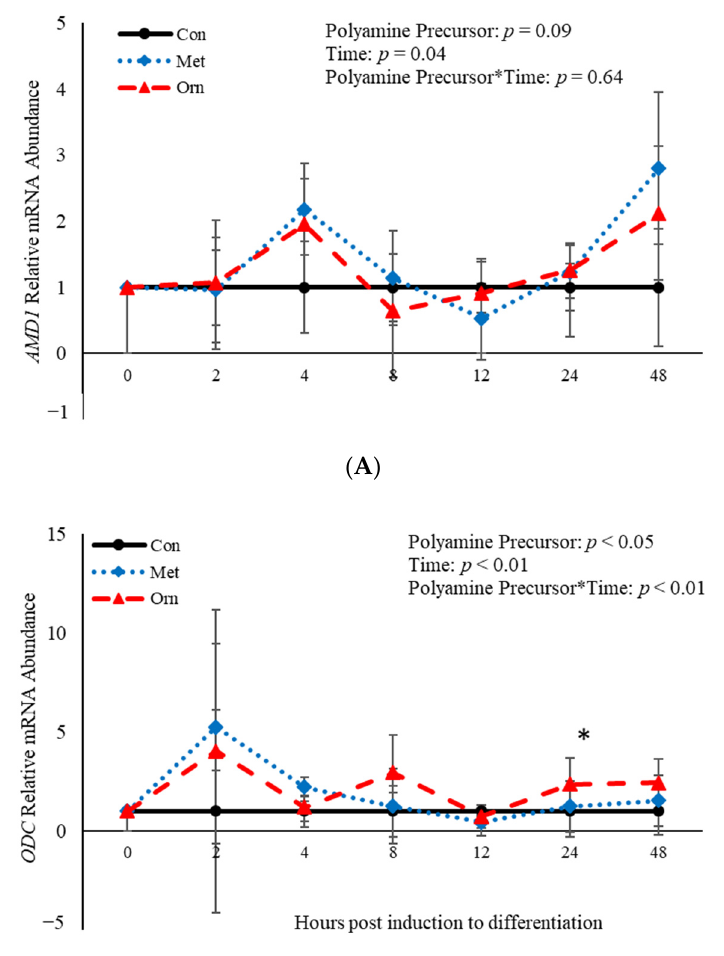
Figure 5. Relative mRNA abundance of S-adenosylmethionine decarboxylase ( AMD1; ( A ) and ornithine decarboxylase (ODC; ( B ) from primary bovine satellite cells cultures following treatment with 10 mM methionine (MET) or 8 mM ornithine (ORN). Cultures were grown to 80% confluency and treated with DMEM/3% horse serum and 10 mM MET or 8 mM ORN. Abundance was measured 0, 2, 4, 8, 12, 24 and 48 h after treatment, as described in the Materials and Methods. The main effects of polyamine precursor, time and polyamine precursor*time in mRNA abundance were analyzed as repeated-measures. Data represent relative mRNA abundance normalized against 18S abundance and are presented as LS mean ± SEM from six separate replicates utilizing BSCs isolated BSCs isolated from at least three different animals. Differences ( p < 0.05) between polyamine precursors and the control cultures are indicated by a * at that particular time point.